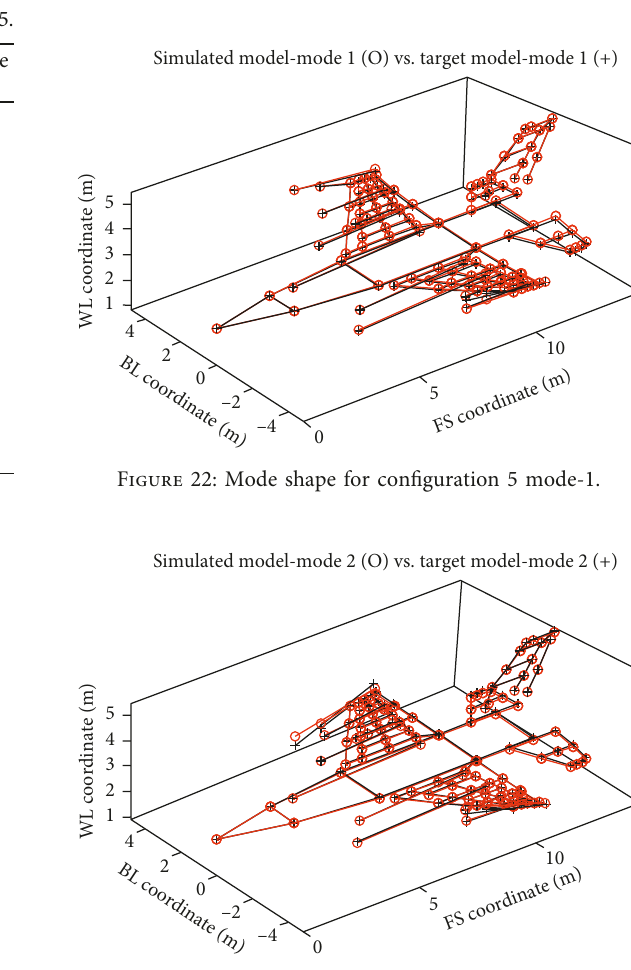
Figure 23: Mode shape for configuration 5